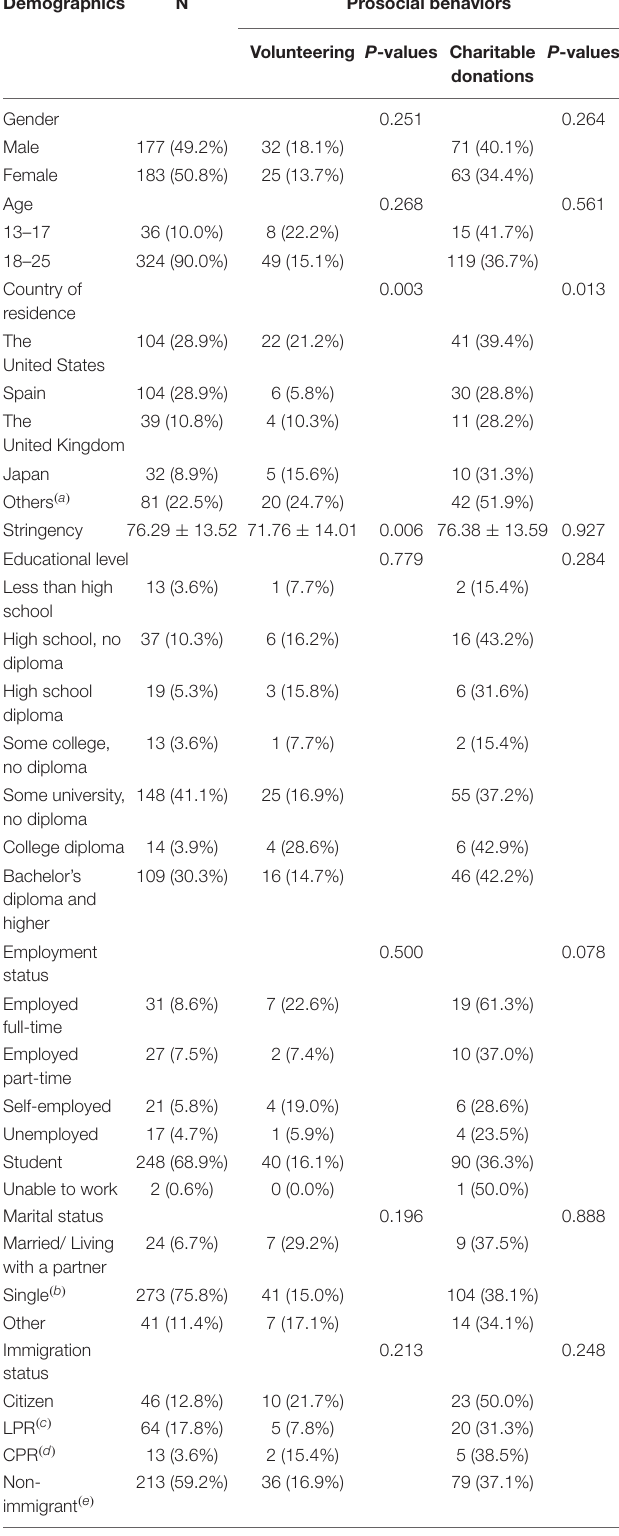
TABLE 1 | Descriptive statistics of participants’ characteristics, prosocial behaviors, perceived discrimination, and